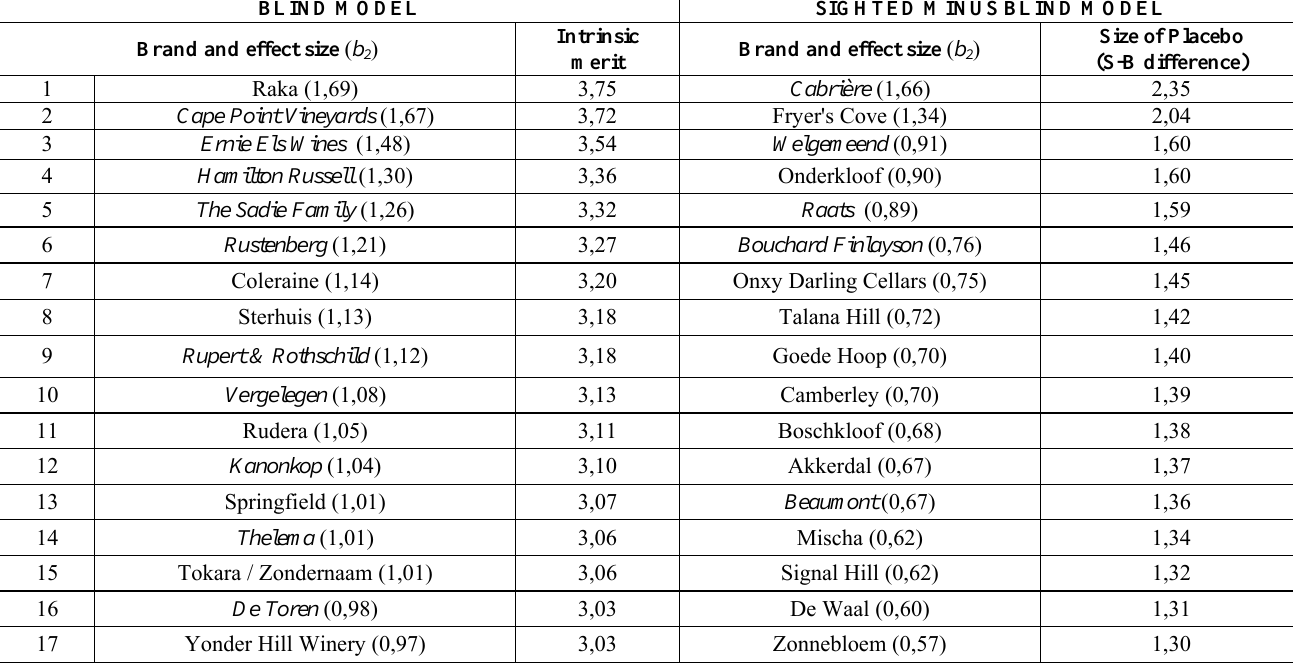
Table 15: The top 30 brand effects derived from the entire-data-set-model: identified for blind and sighted-to-blind assessments . The cited brands present without cultivar controls and appear with their respective functional and symbolic brand effect ( b ) in parenthesis. Predicted intrinsic and placebo scores are fitted values and should be noted in relation to the 2 blind and sighted-to-blind score averages of 2,59 and 0,92, respectively. Italicised brands also feature in the Top 30 cultivar- specific brand listing in Table